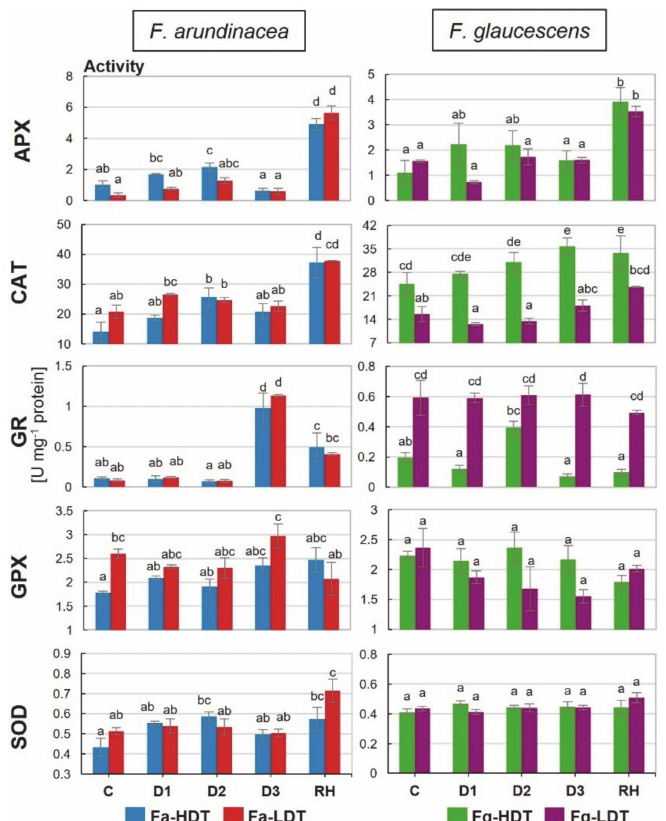
Figure 4. The activity of L-ascorbate peroxidase ( APX ), catalase ( CAT ), glutathione reductase ( GR ), glutathione peroxidase ( GPX ) and superoxide dismutase ( SOD ) in two genotypes of F. arundinacea (Fa-HDT, Fa-LDT) and F. glaucescens (Fg-HDT, Fg-LDT) before stress treatment (C), on the 3rd (D1), 6th (D2), and 11th (D3) day of water deficit and 10 days after re-hydration initiation (RH). Error bars represent the standard errors (SE) of three biological and two technical replicates. Homogeneity groups are denoted by the same letters, according to Fischer LSD test ( p =